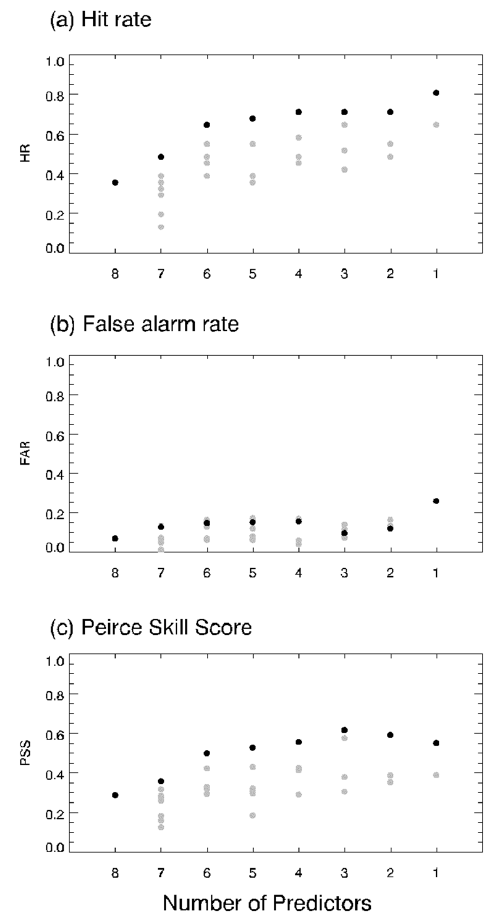
Figure 1. ( a ) Hit rate (HR), ( b ) false alarm rate (FAR), and ( c ) the Peirce skill score (PSS) compared for di ff erent selections of potential predictors in the Linear Discriminant Analysis (LDA) model. Each gray dot shows the performance of a di ff erent combinations of predictors and the black dot represents the highest performance in terms of